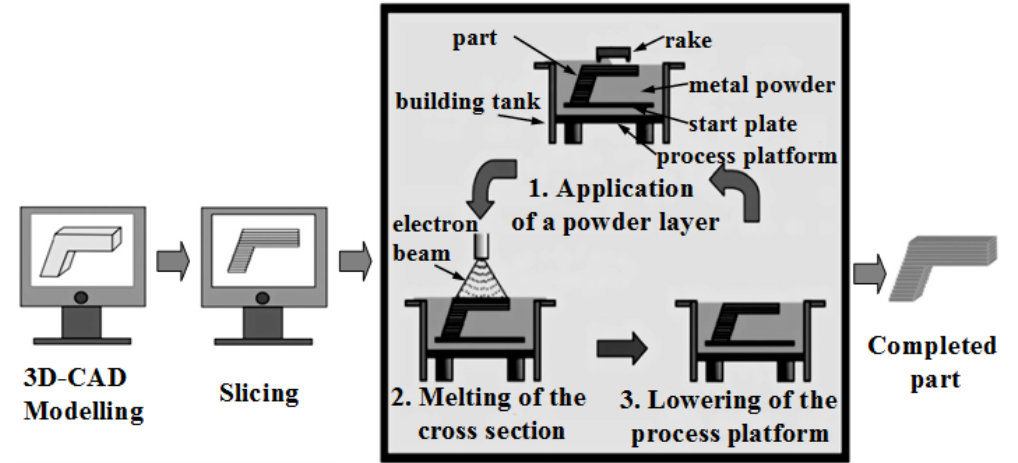
Figure 37. Schematic explaining the additive manufacturing by selective electron beam melting used to generate titanium bodies with a cellular structure [55]. Reprinted with permission from [55].Copyright 2008